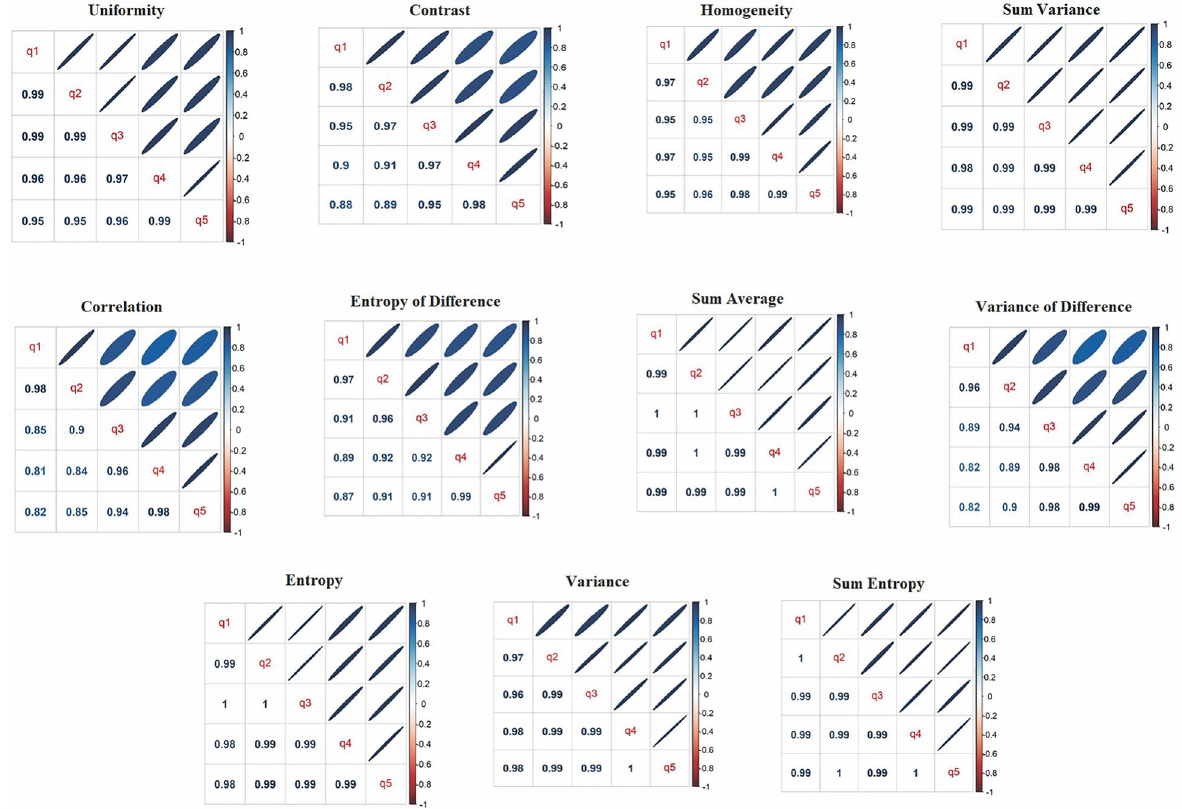
Figure 3. Correlation plots provide visual representation of the relationship between every texture parameters and the five positions based on Spearman’s correlation coefficient. Narrower ellipses indicate stronger correlations. The distances were organized according to the five directions in the following positions: q1, q2, q3, q4 and